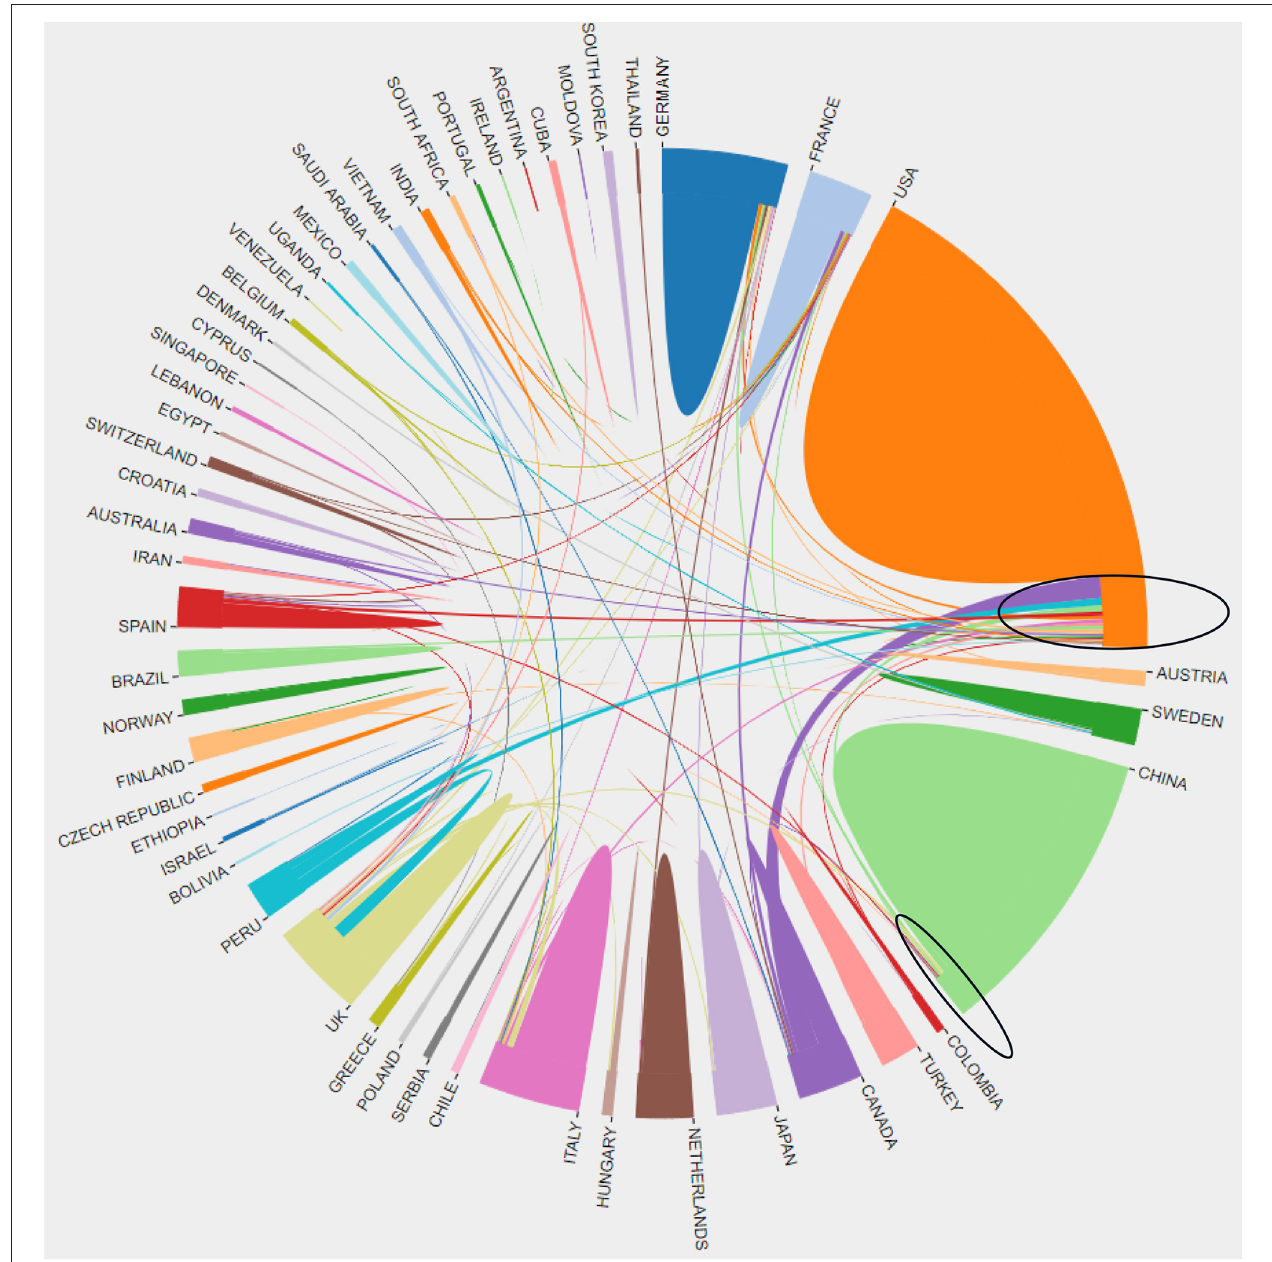
FIGURE 5 | The cooperation of countries/regions in MODS from 2001 to 2021. on Sepsis and Septic Shock (Sepsis-3)” defined sepsis as a life- threatening organ dysfunction caused by a dysregulated host response to infection, reflecting that MODS was the terminal stage of sepsis (26). This new definition of sepsis triggered a climax of MODS research. Given the periodicity of the publications, it was not difficult to understand the blowout of MODS-related articles in